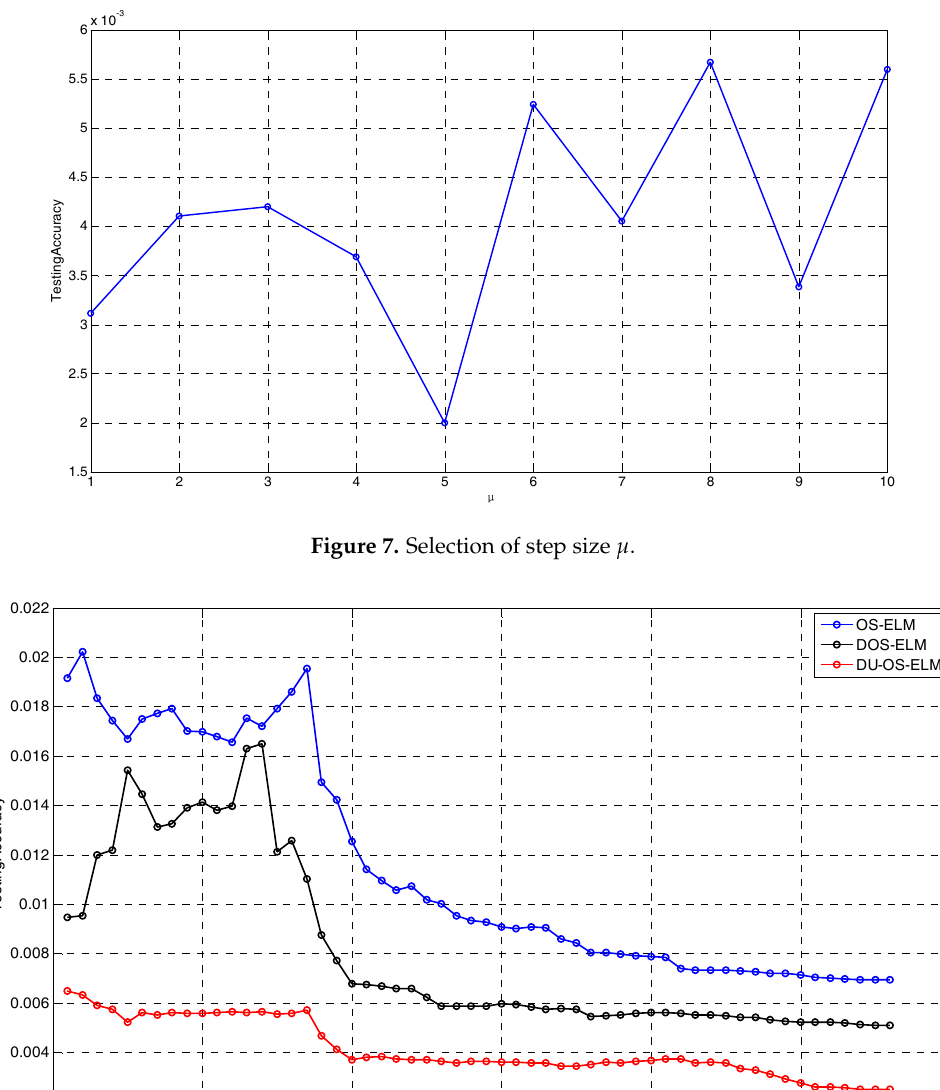
Figure 8. Change trends comparison among OS-ELM, DOS-ELM and DU-OS-ELM.